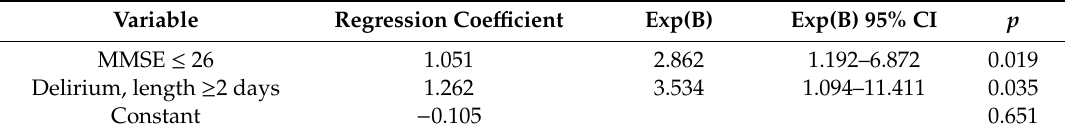
Table 4. Multiple regression